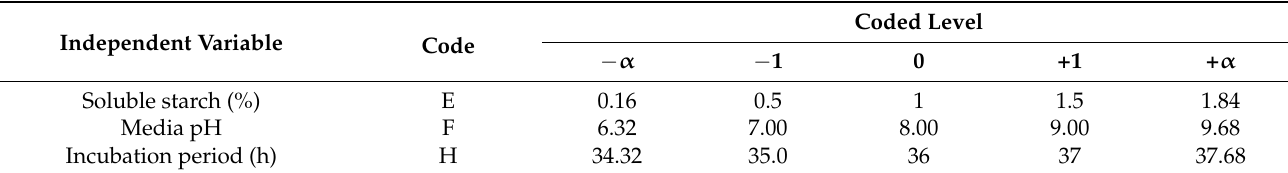
Table 7. Range of values for the response surface method,